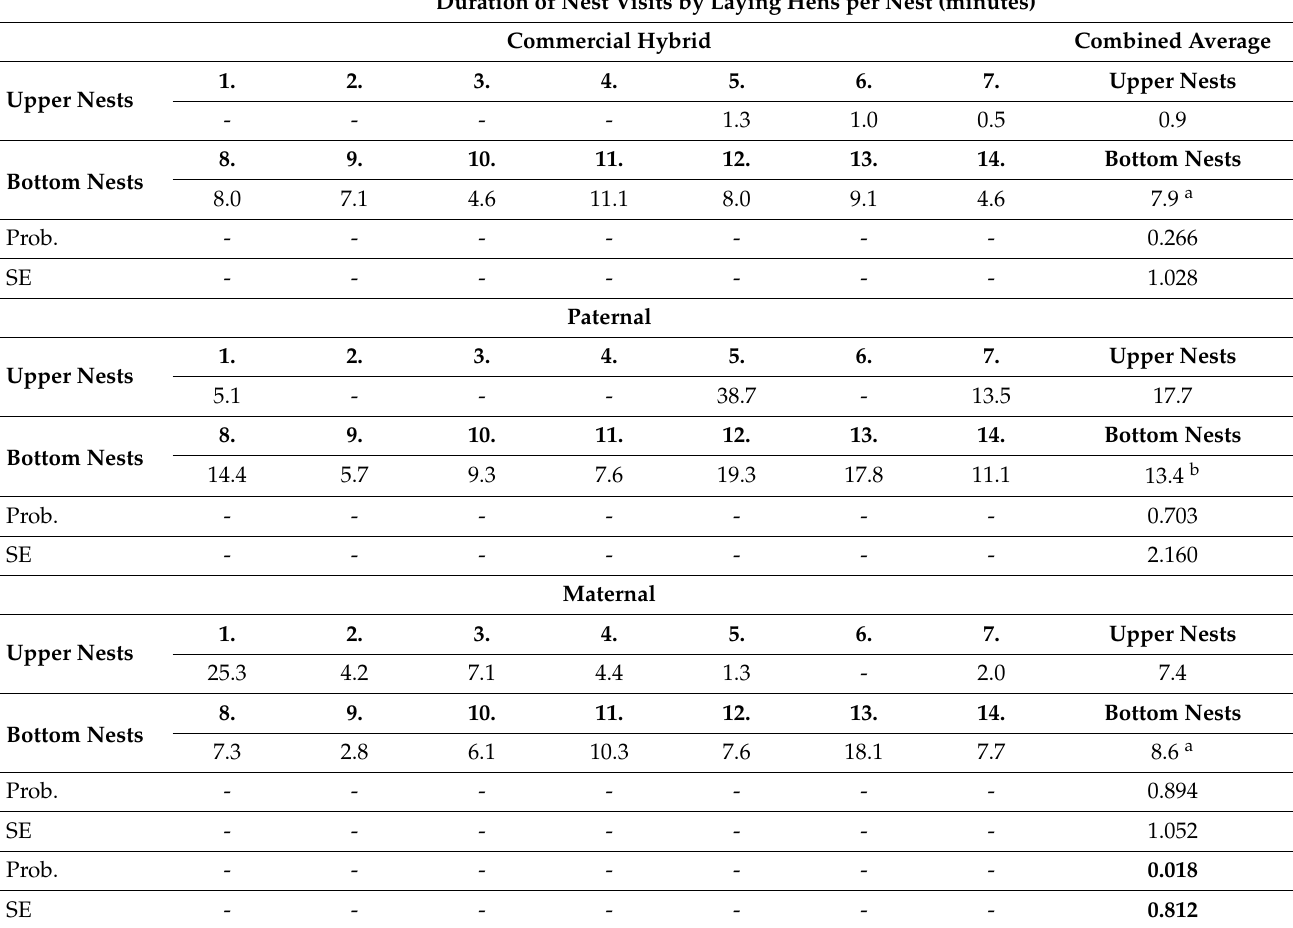
Table 4. The change of the average duration of the nest visits of the laying hens per egg nest (in